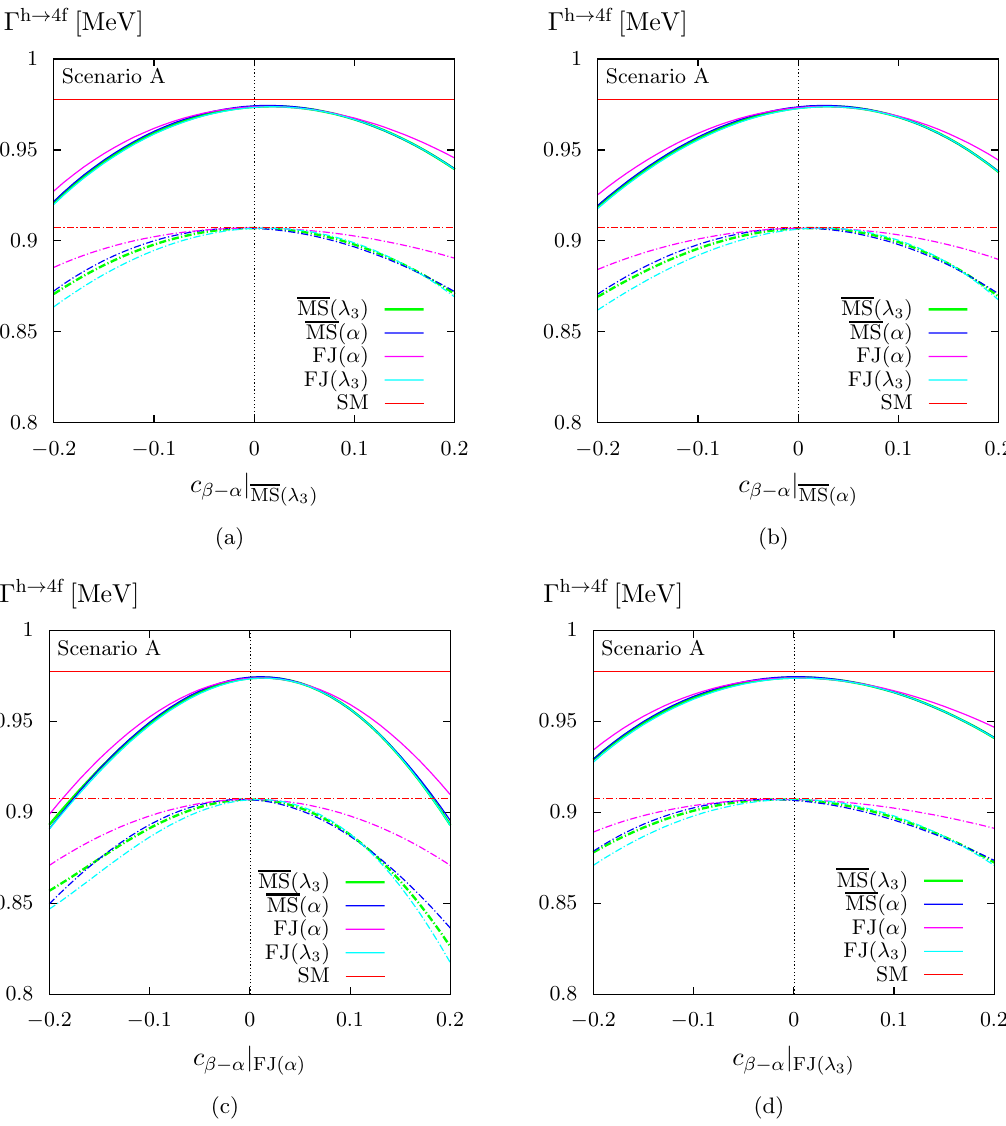
Figure 12 . The h 4 f width at LO and full NLO EW+QCD (solid) for scenario A in dependence ! of c (cid:12) (cid:0) (cid:11) . The panels (a), (b), (c), and (d) correspond to input values de(cid:12)ned in the MS( (cid:21) 3 ), MS( (cid:11) ), FJ( (cid:11) ), and FJ( (cid:21) 3 ) schemes, respectively. Parameters are consistently converted between the renormalization schemes (both for NLO and LO predictions) by numerically solving the non- linear matching equations (4.1). Results in the di(cid:11)erent target schemes are displayed with the colour code of (cid:12)gure 9, and the SM (with a SM Higgs-boson mass of M h ) is shown for comparison in red. Note, that the solid green, blue, and turquoise lines are very close and partly on top of each